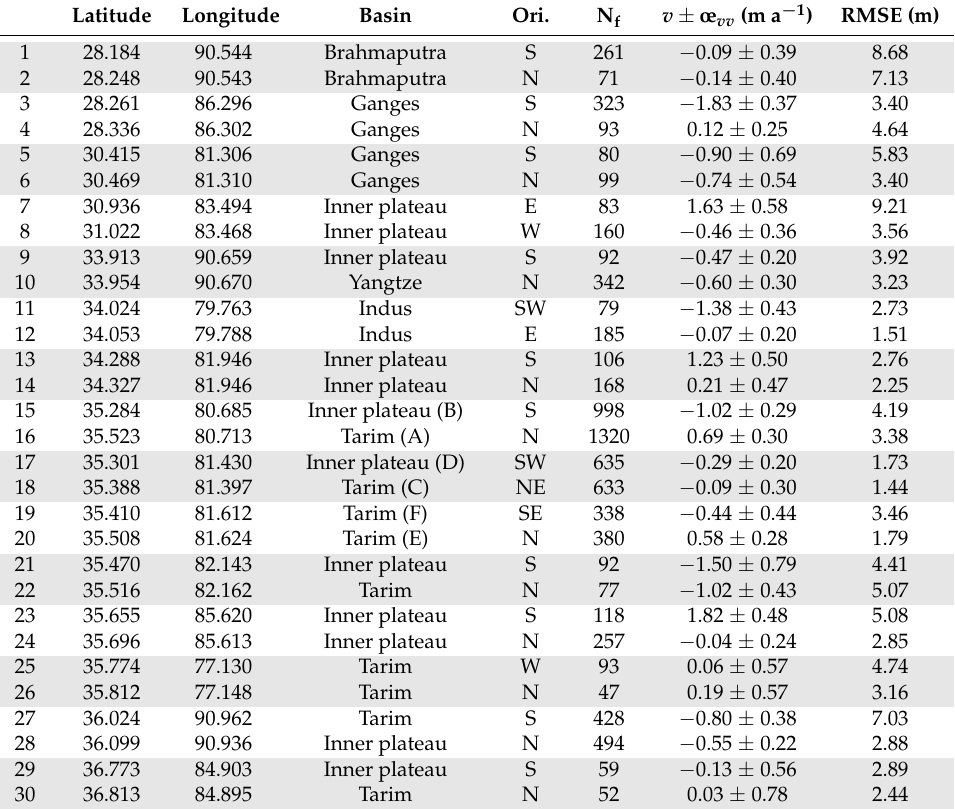
Figure 7. Different rates of glacial thickness changes between 2003 and 2009 at the north and south face of the Western Kunlun Mountains The figure is created by overlaying the GLIMS glacier outlines on the Landsat 8 OLI/TIRS image from 11 September 2013, and adding the locations of observed glaciated areas with thickness change rates. Table 4. List of pairs of glaciated areas that are adjacent, but located on opposite sides of the main mountain ridge. Here, N f is the total number of accepted footprints. Locations A, B, C, D, E and F are indicated in Figure 7.